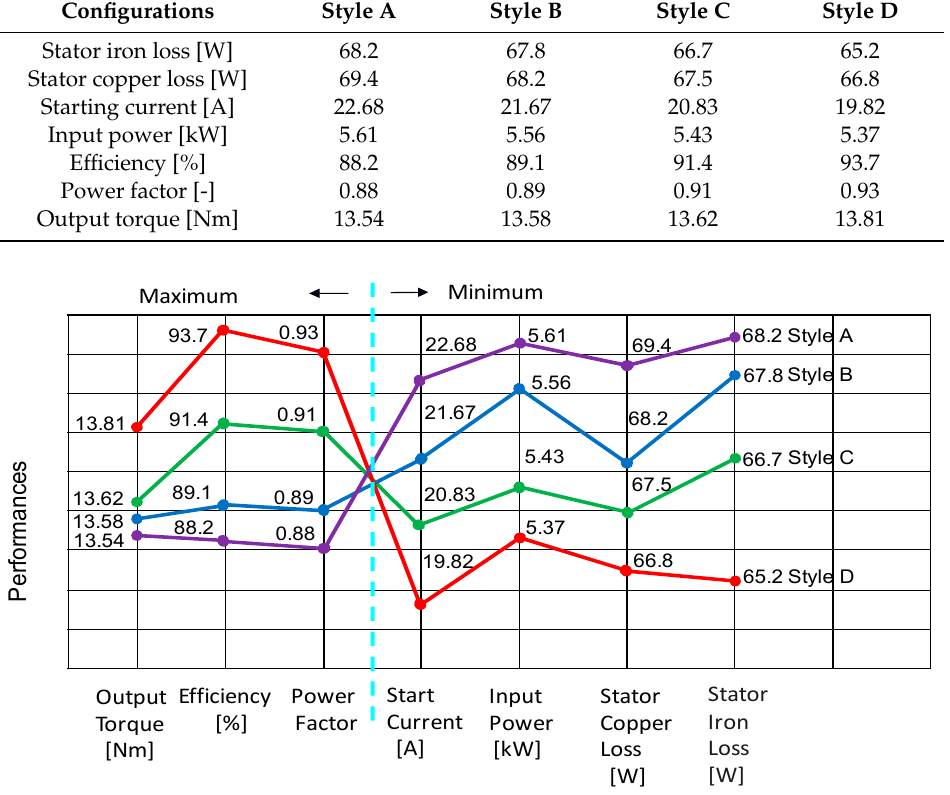
Figure 6. Poly-line graph of stator copper loss for four kinds of SCSCRIMs under several speeds.